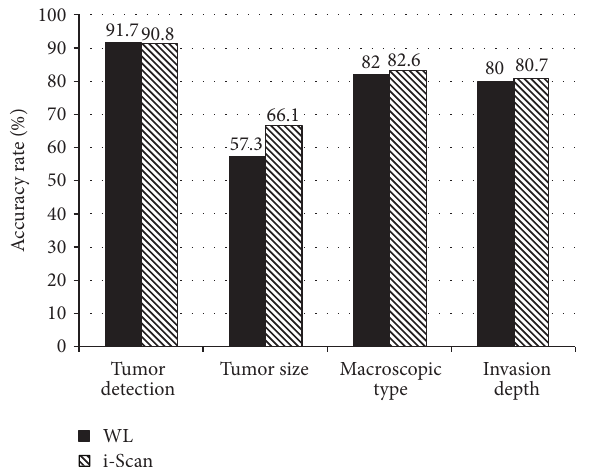
Figure 3: Outcome of tumor evaluation using white light (WL) and i-Scan moving images originally recorded in twin mode.